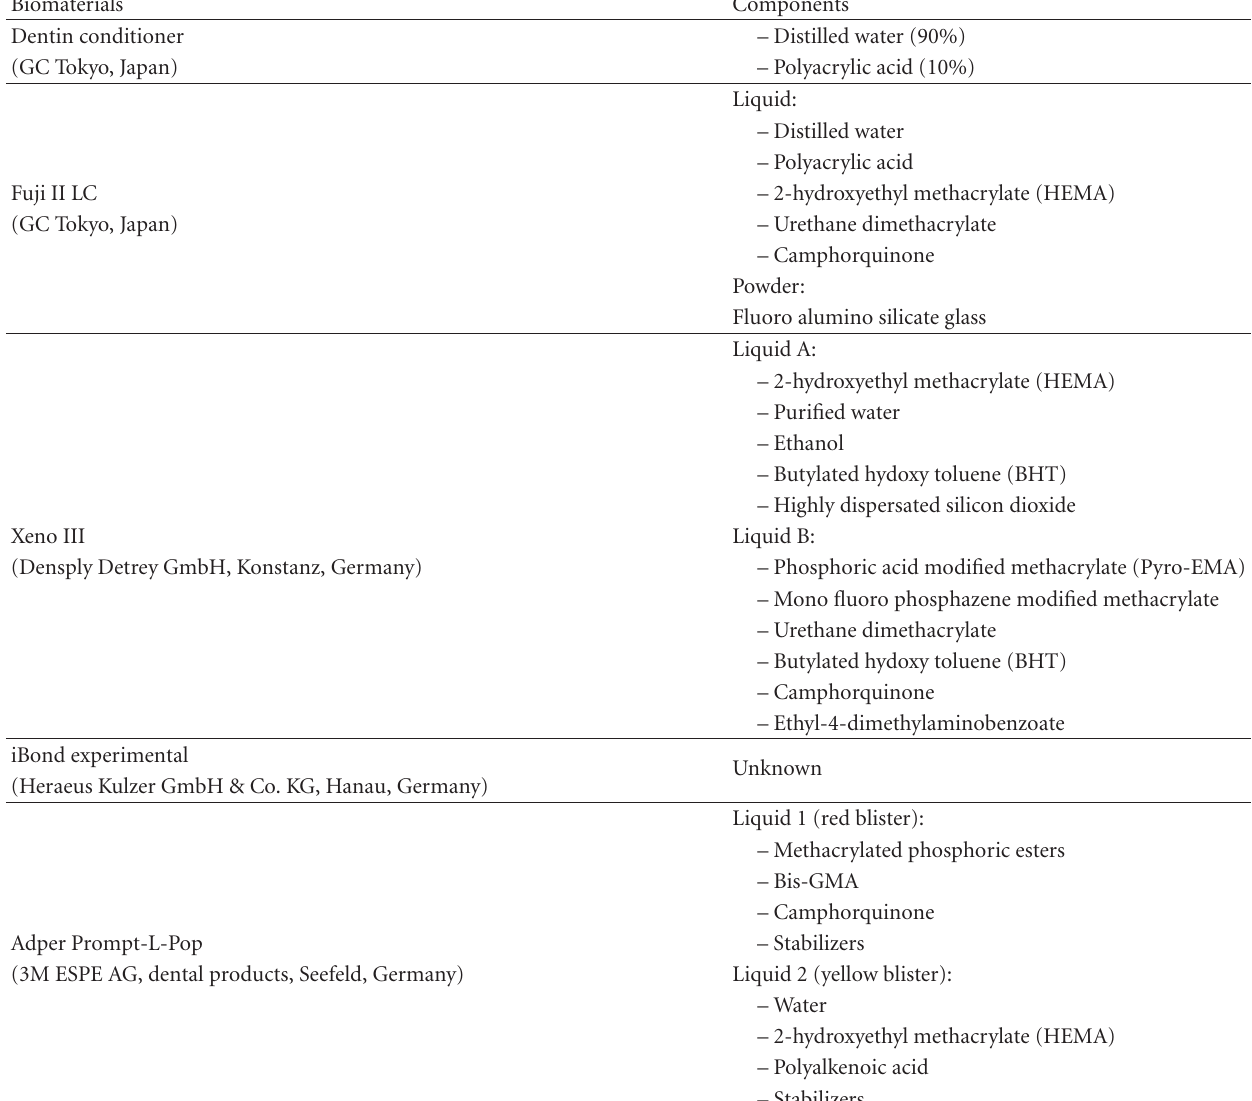
Table 2: Composition of biomaterials used in the present study.